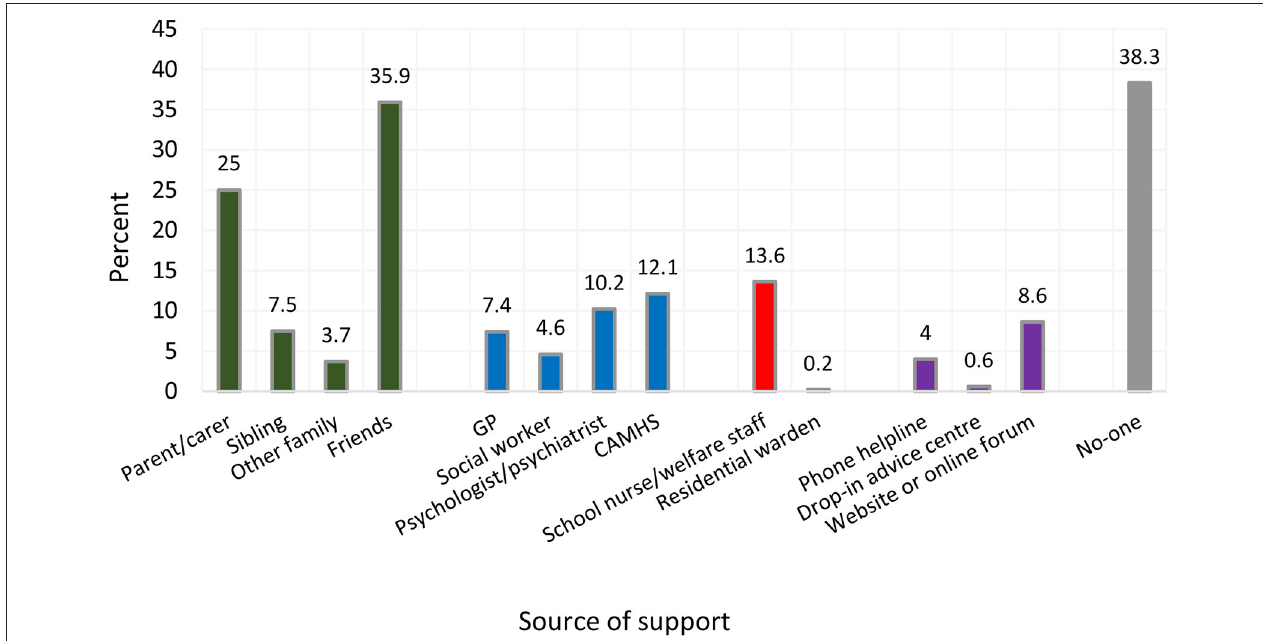
FIGURE 2 | Source of support accessed following self–harm, weighted proportions a . a Weighted to account for differences in the distribution of selected sociodemographic variables between the study sample and the target population.